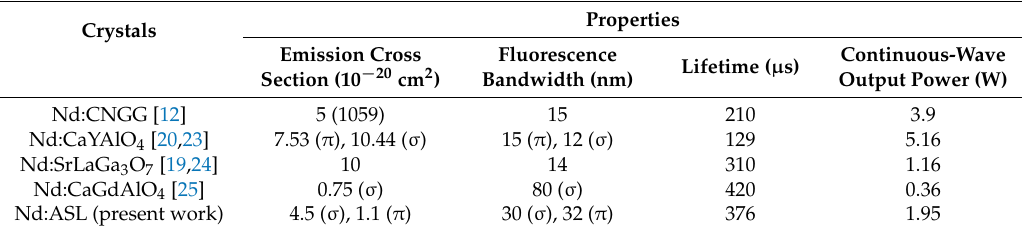
Table 4. Optical parameter values of some laser materials.